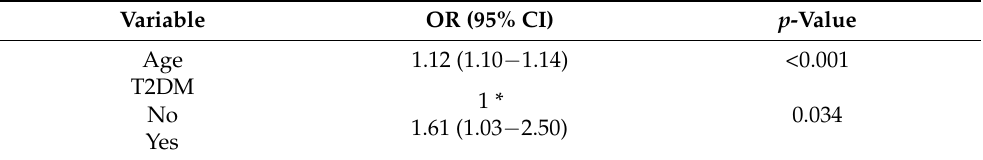
Table 3. Multivariate logistic regression model between edentulism and the independent